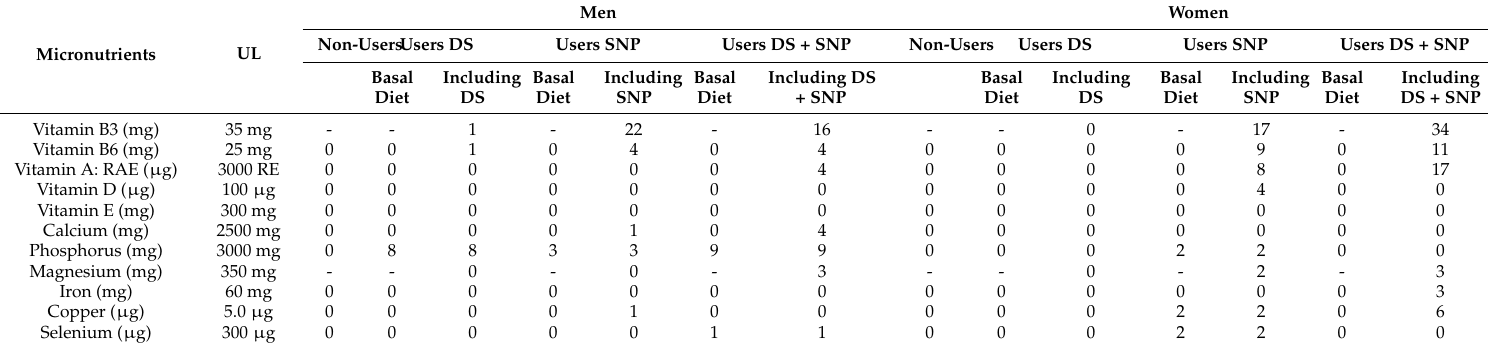
Table 5. Prevalence (%) of athletes exceeding Upper Level (UL) of selected micronutrients based on mean intake for men and women split by non-users and users of nutritional